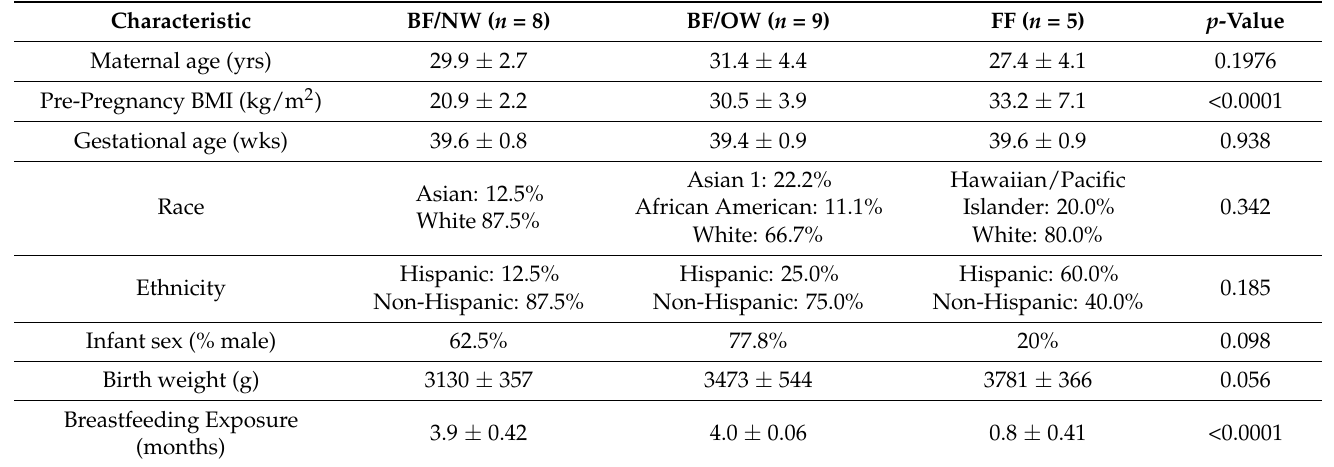
Table 1. Participant characteristics of mother and infant